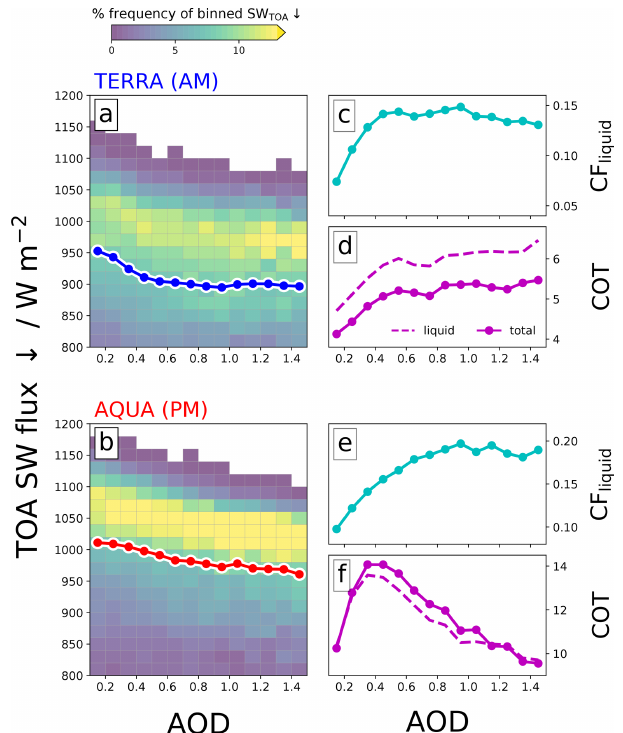
Figure 10. CERES TOA net downward SW flux as a function of AOD (a–b) for the morning TERRA overpass (a) and the afternoon AQUA overpass (b) . Joint histograms show % frequency of SW TOA binned by AOD, and coloured lines show the mean in each AOD bin. The column on the right (c–f) shows the MODIS-retrieved mean CF liquid (c, e) and the mean COT (d, f) binned by AOD for the corresponding satellite overpasses. COT is shown for both COT total (solid) and COT liquid